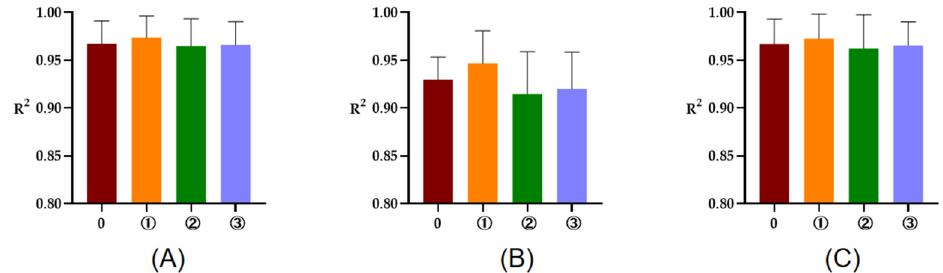
Figure 1. The R 2 of fitted curve of DM, CP, and OM of protein feeds of 5 or 7 time points. ( A – C ), respectively, represent the R 2 of fitted curve of DM, CP, and OM in the rumen of protein feeds. The number 0 = 7 incubation time points, ① , respectively, the R 2 of fitted curve of 2, 16, 24, 36, 48 h; ② , respectively, the R 2 of fitted curve of 2, 8, 16, 24, 48 h; ③ , respectively, the R 2 of fitted curve of 2, 8, 16, 36, 48 h.